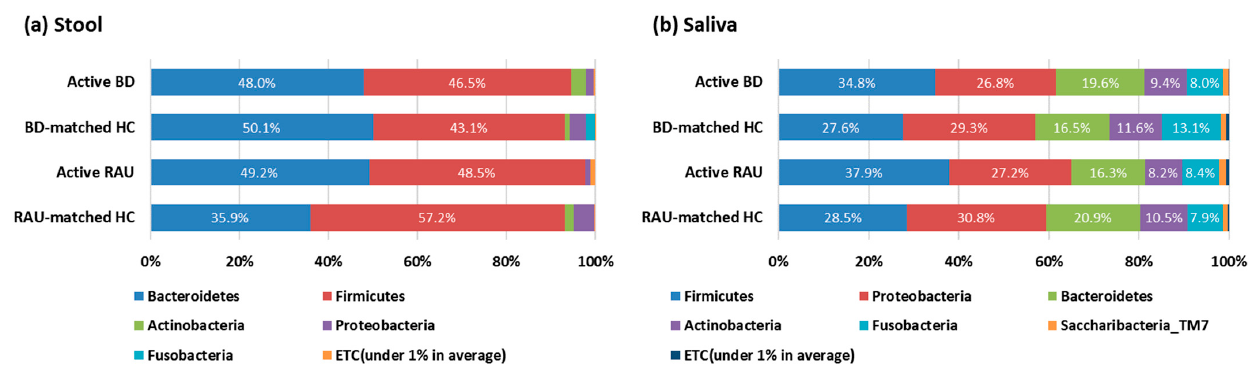
Figure 3. Average taxonomic compositions of the microbiomes (phylum level). In stool ( a ), the phyla Bacteroidetes and Firmicutes were the most frequent taxa in the active BD, BD-matched HC, active RAU, and RAU-matched HC groups. In saliva ( b ), the phyla Firmicutes , Proteobacteria , Bacteroidetes , Actinobacteria , and Fusobacteria were the most prevalent taxa in all groups. BD, Behçet’s disease; RAU, recurrent aphthous ulcer; HC, healthy control.